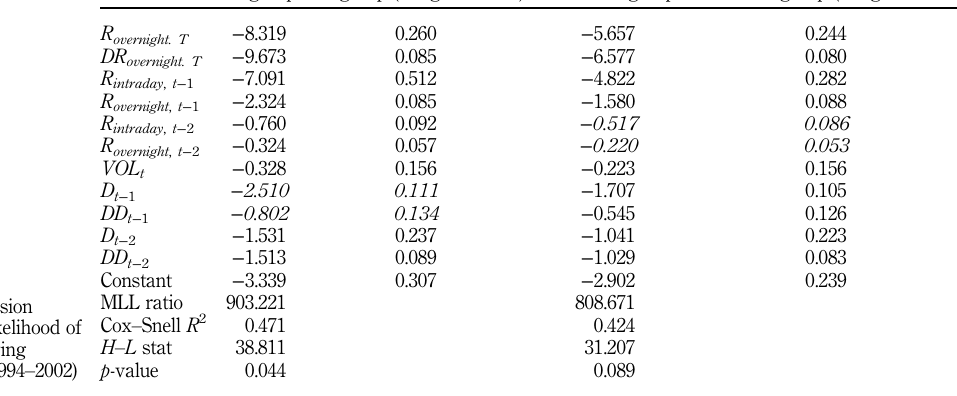
Table III. Logit regression report on likelihood of ceiling hit during Regime 3 (2013 – 2017)